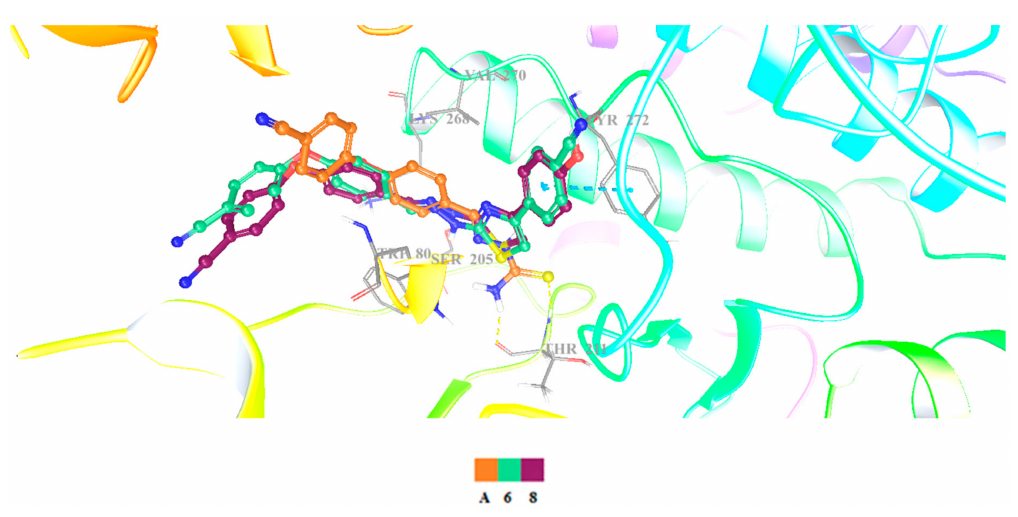
Figure 3. Docked poses of compounds A , 6 and 8 in the active site of Akt (Yellow dashes: Hydrogen bonding; Blue dashes: π – π interactions).